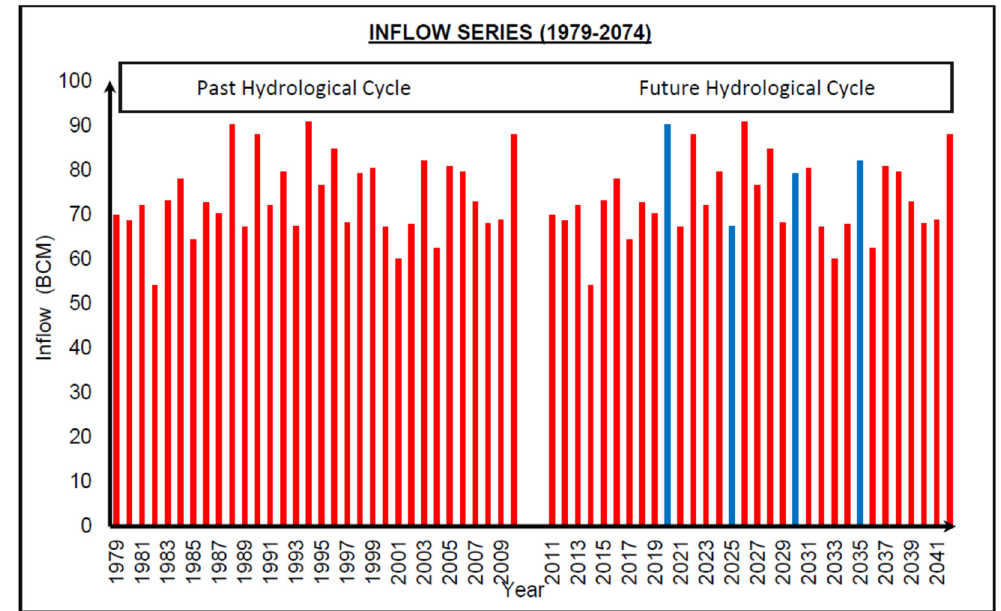
Figure 20. Future Application Years Hydrological Cycle.